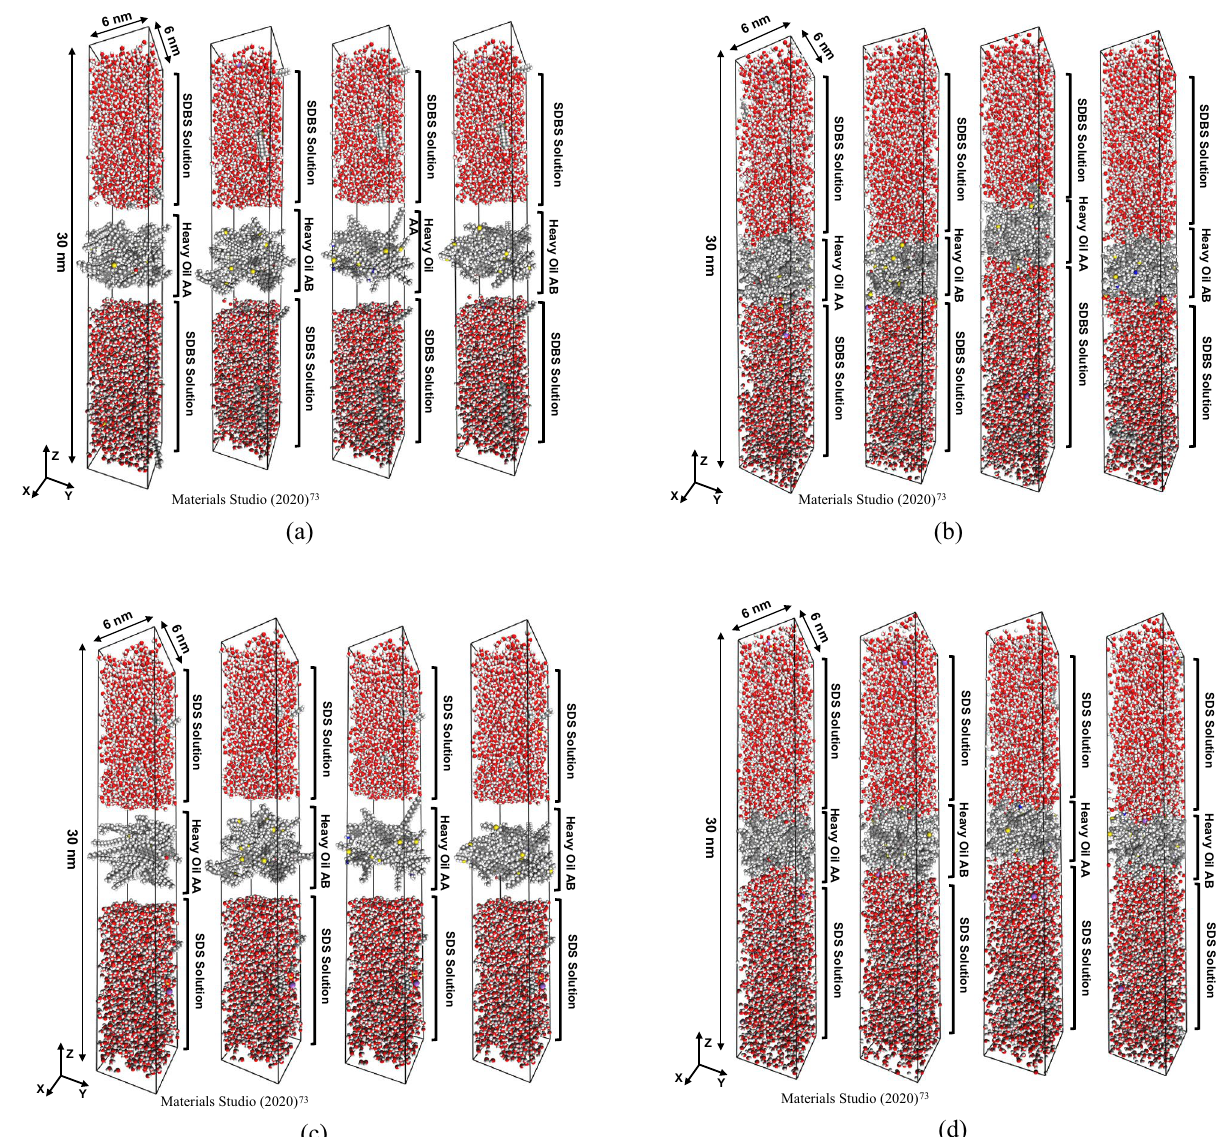
Figure 2. Snapshots of the initial and final configurations of simulation boxes: ( a ) SDBS initial configuration, ( b ) SDBS final configuration, ( c ) SDS initial configuration, and ( d ) SDS final